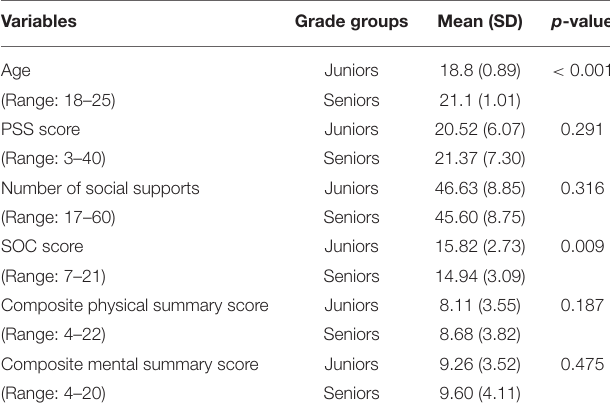
TABLE 3 | Characteristics of the participants and comparisons of demographic variables by grade groups. Variables